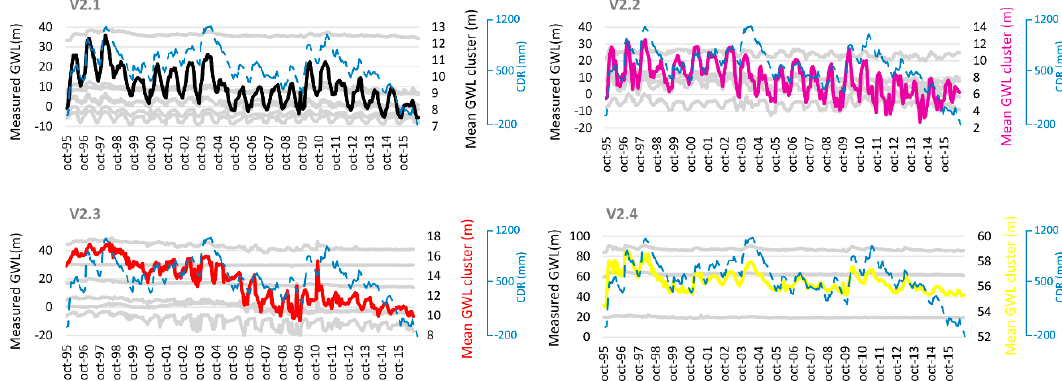
Figure 5. GWL series (grey lines), mean of the GWL cluster series (colored lines) from October 1995 to September 2016 by visual clustering and cumulative deviation from the mean monthly rainfall (CDR).